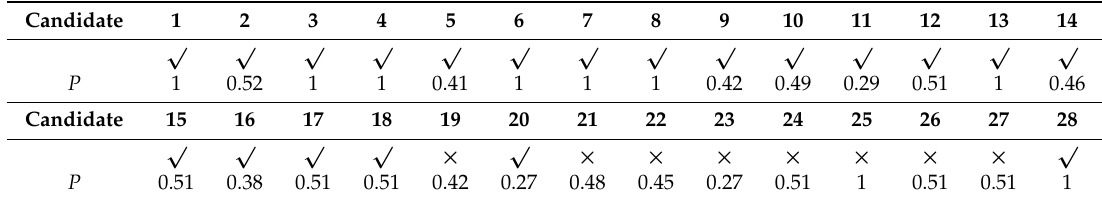
Figure 15. Confidence probabilities ( a ) and doubted results ( b ) for test image ID 1. Table 7. Final discrimination results based on CeD (certain discrimination based on features) and CoD for test image ID 1 ( √ represents ship target and × represents false alarms, P is the confidence probability).